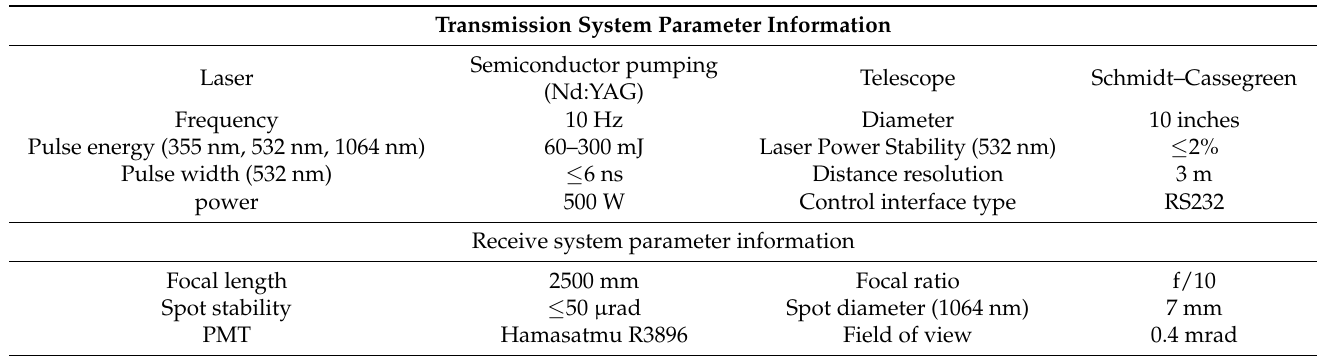
Table 1. The system parameters of the Mie-scattering lidar. Transmission System Parameter